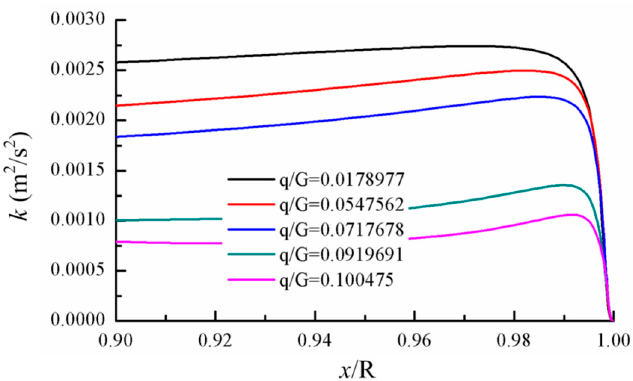
Figure 14. Distribution of the axial velocity ( x/D = 13.2). Energies 2017 , 10 , 1870